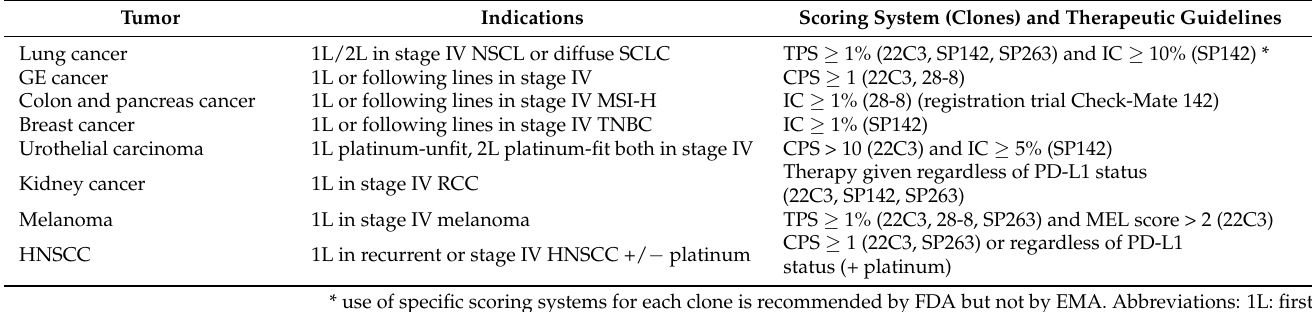
Table 1. Currently approved therapeutic indications, clones and scoring systems for immunohisto- chemical evaluation of PD-L1